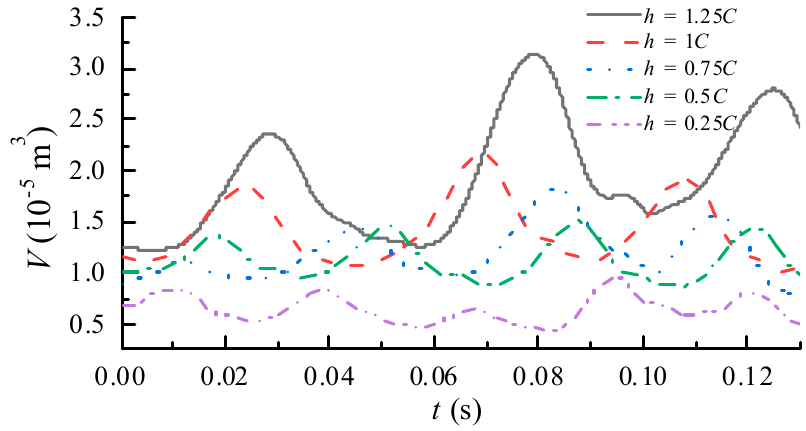
Figure 15. Comparison of the cavity volume fluctuations for five different water depths.